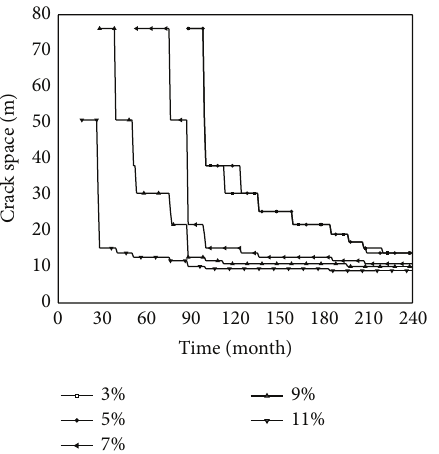
Figure 7: Influence of air voids in asphalt concrete on thermal cracking space on asphalt pavement.